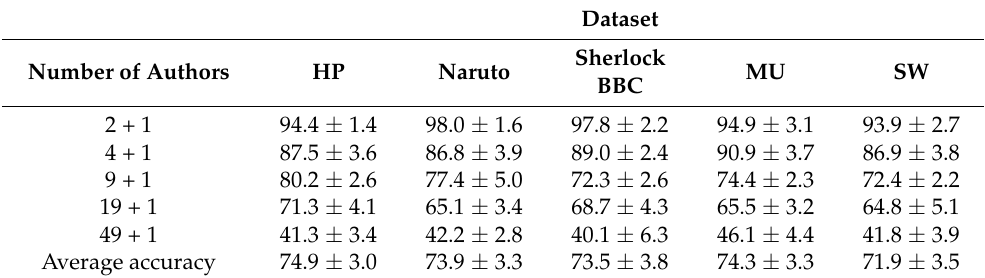
Table 15. Method based on SoftMax thresholding using fastText for in-group classification.